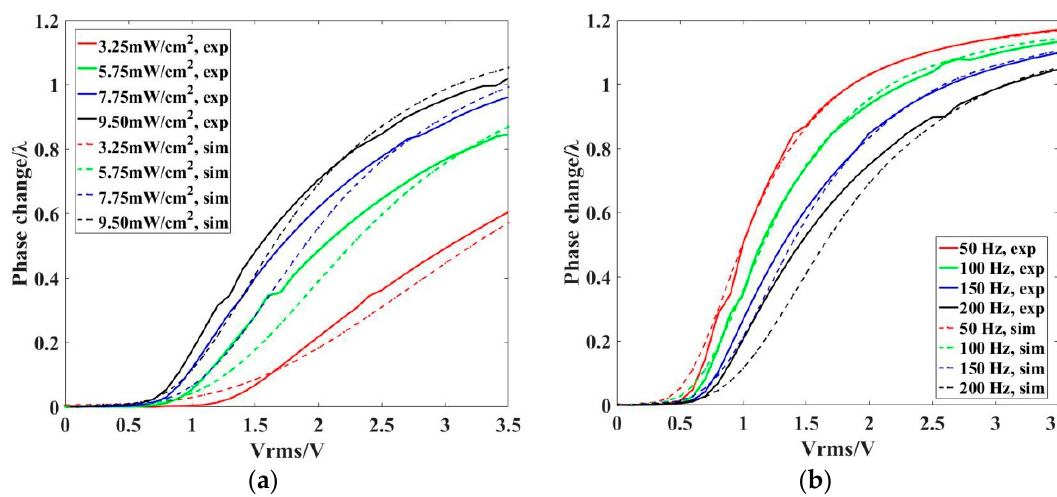
Figure 3. ( a ) Phase change varies with (cid:1848) (cid:3002)(cid:3004) at 200 Hz when the OALCLV is illuminated by the different write light, the (cid:1848) (cid:3045)(cid:3040)(cid:3046) is the RMS value of the (cid:1848) (cid:3002)(cid:3004) . ( b ) Phase change varies with (cid:1848) (cid:3002)(cid:3004)